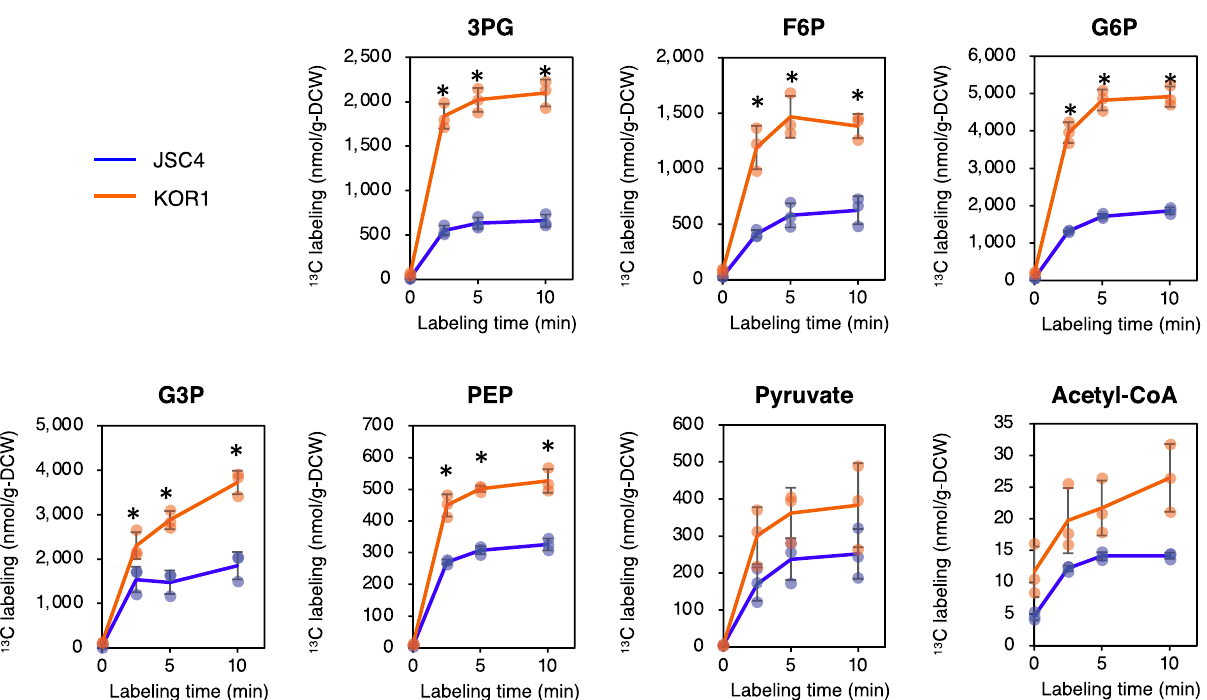
Fig. 6 Dynamic metabolic pro fi les under illuminated conditions. Cells grown under the light/dark conditions for 5.5 days were harvested and resuspended in medium containing NaH 13 CO 3 . Vertical axes: level of 13 C-labeled metabolites calculated by multiplying metabolic pool size with 13 C-labeled ratio. Horizontal axes: labeling time after starting 13 C supply to the cells. Error bars indicate the standard deviation of three replicate experiments (* p < 0.05 by Welch ’ s t test).